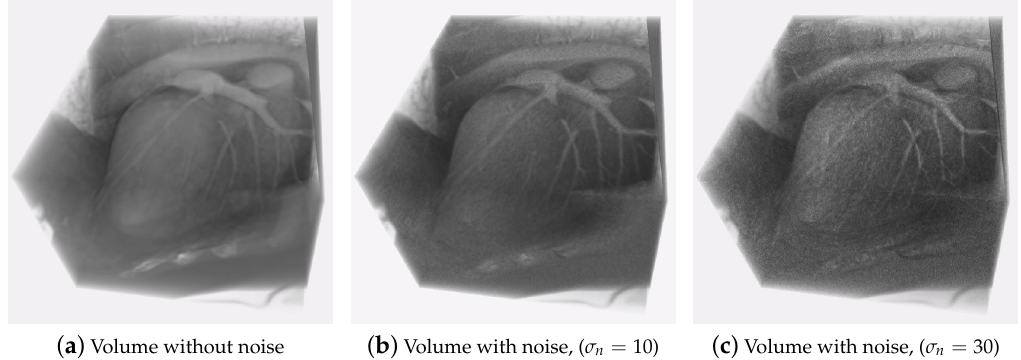
Figure 13. Volume with pseudo-random noise.